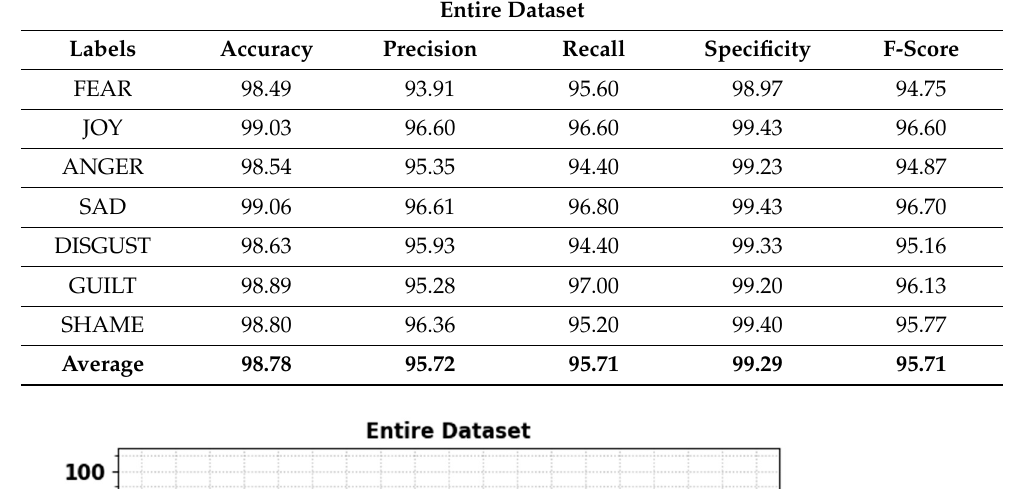
Table 2. Result analysis of CLBEDC-SND approach with distinct class labels under entire dataset.